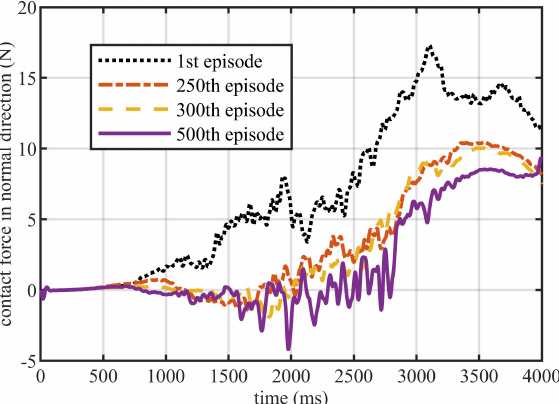
Figure 15. The curve of the contact force between the robot and the door in the direction parallel to the panel in different training